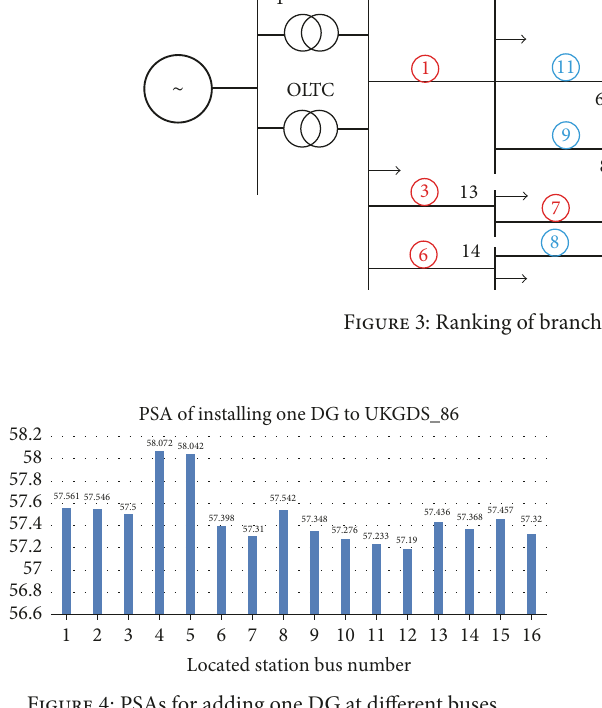
Figure 5: Δ PSA of branch 2-4 with different